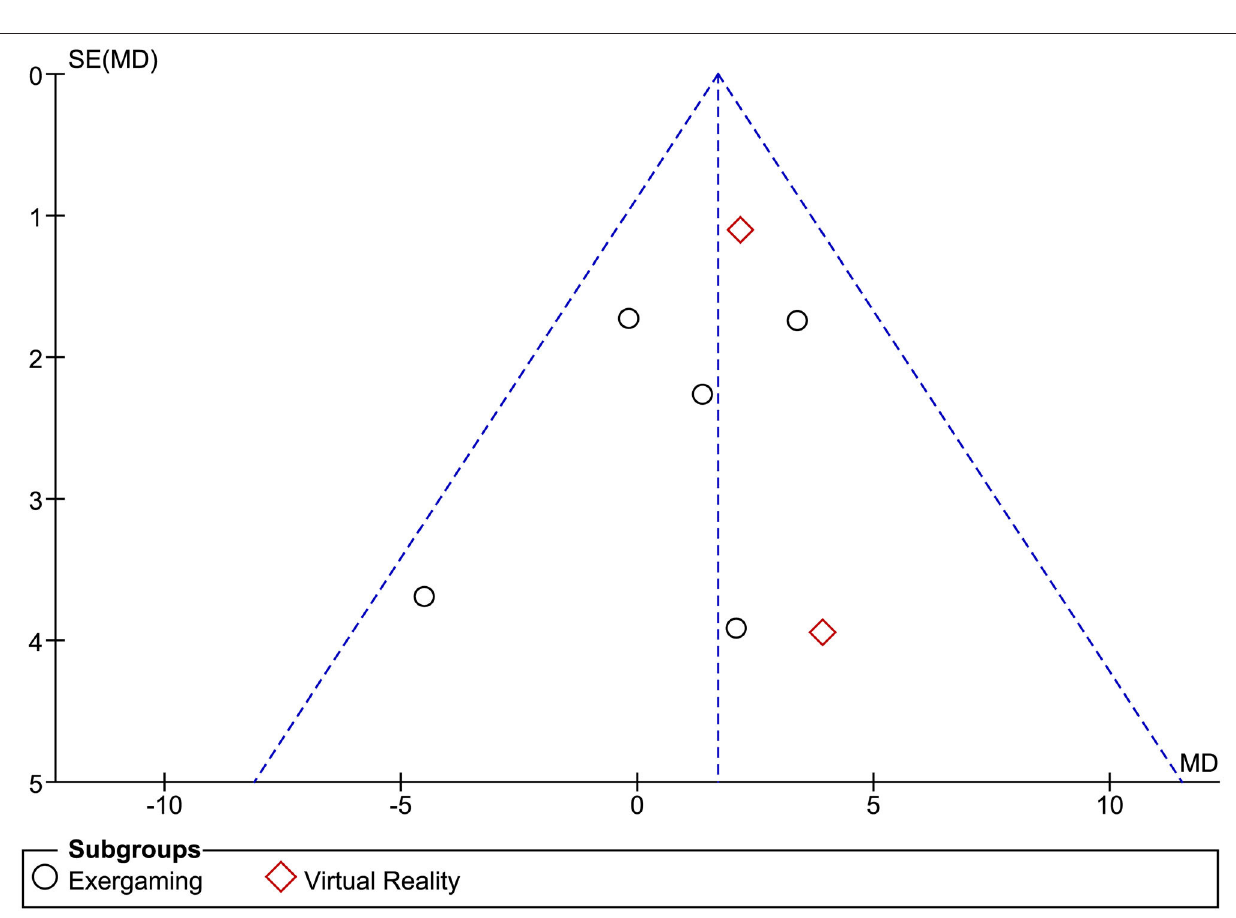
Frontiers in Neurology |